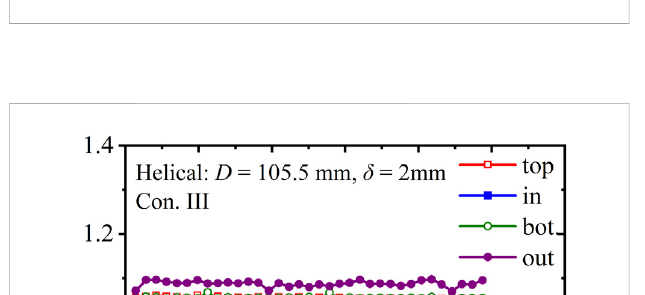
FIGURE 5 Axialheattransfercoef fi cientsalongstraighttubeswithvariouswall thicknesses (Con. III: G in = 1, 260 kg).